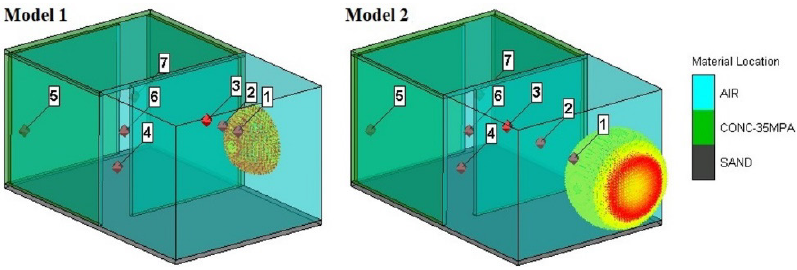
Figure 6. Models 1 and 2 discretized in Autodyn.